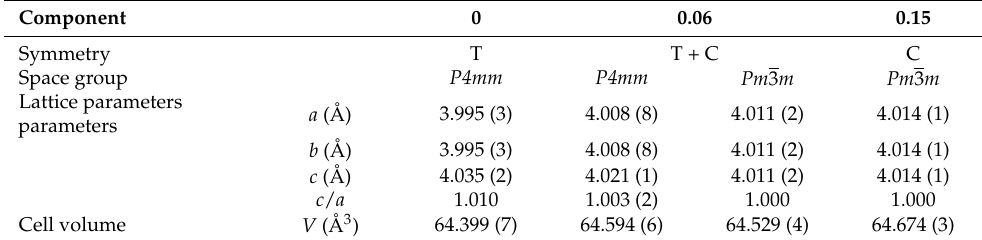
Table 1. The crystal structure and refined lattice parameters of (1 − x )BT- x CSZ ceramics.